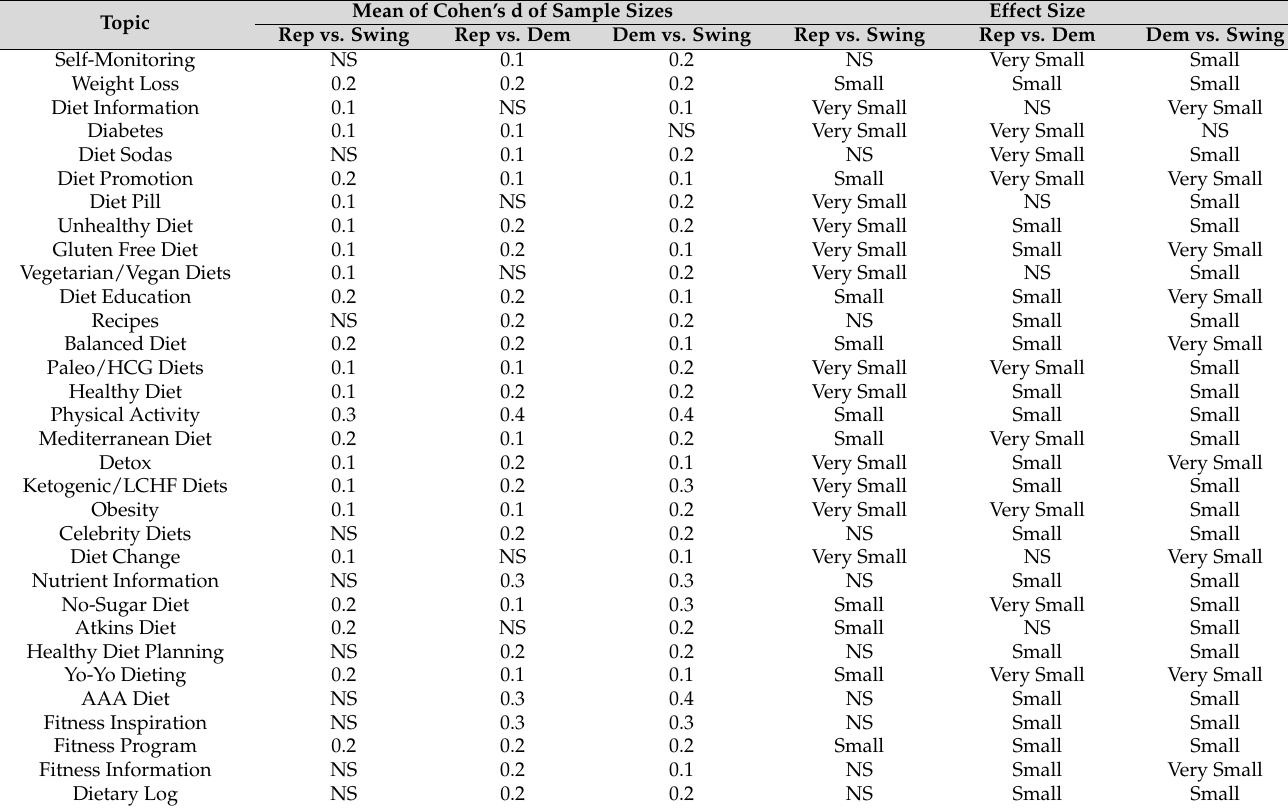
Table 4. Top-10 high-weight topics of democratic, republican, and swing states.